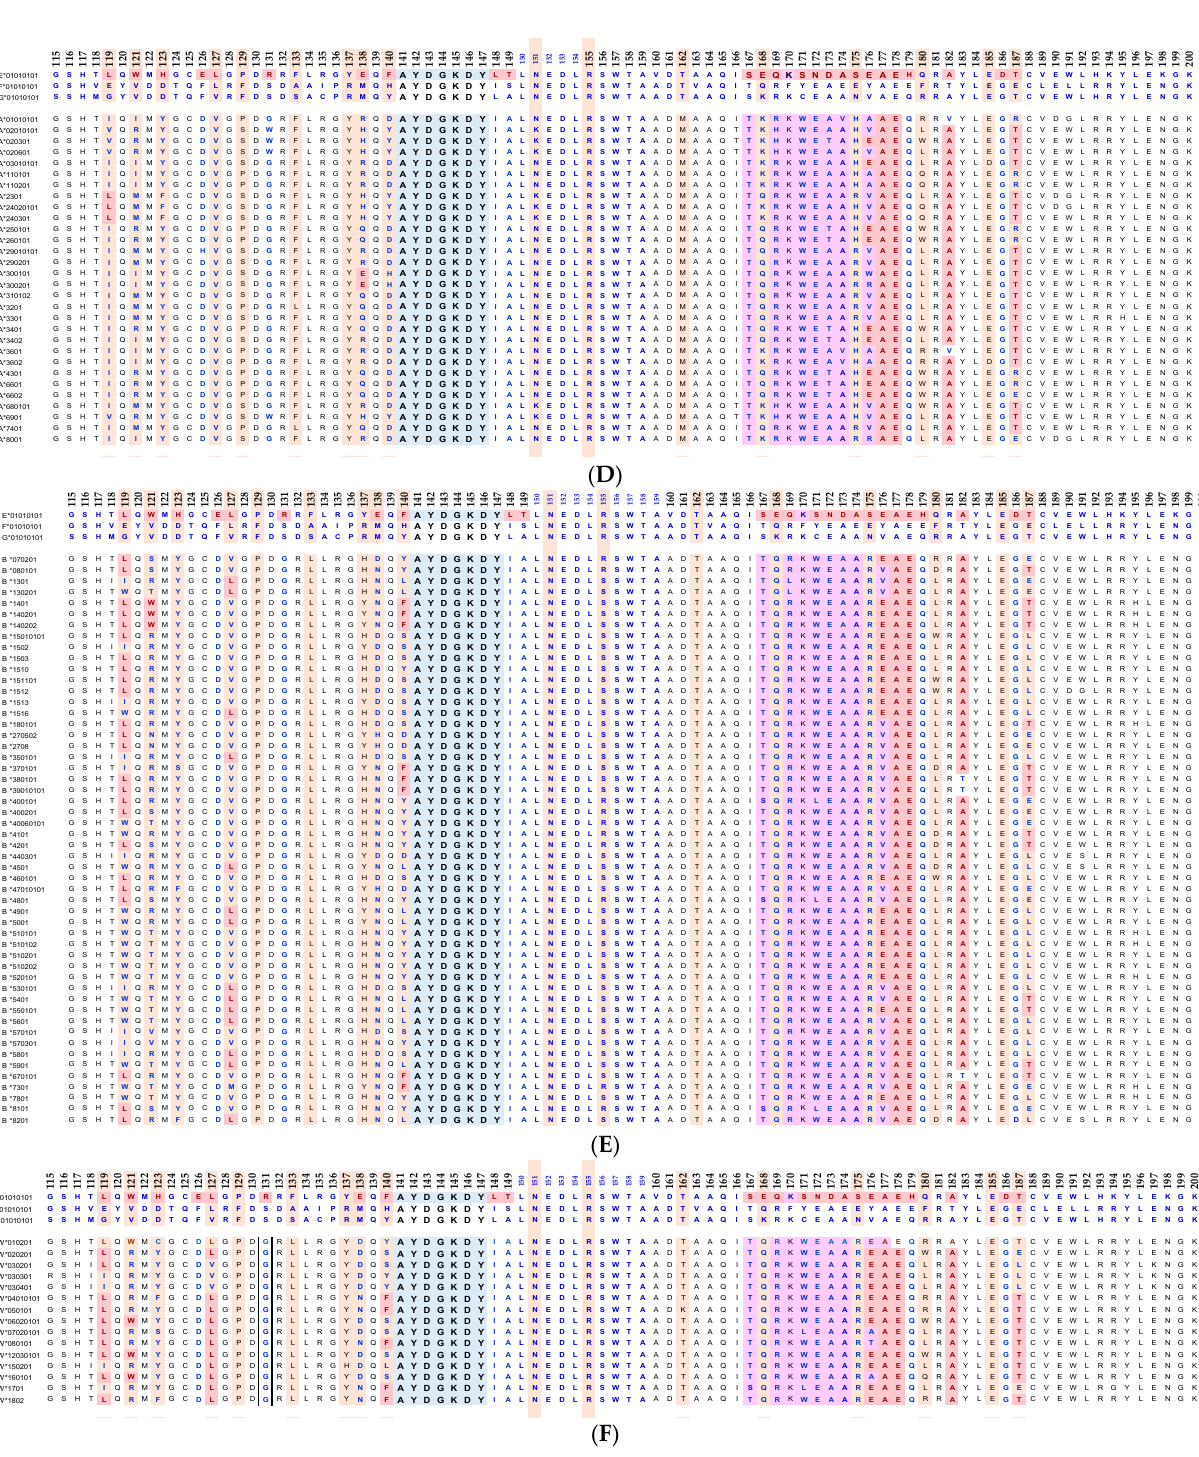
Figure 4. An overview of the polymorphic amino acid sequences of α 1 and α 2 domains in the classical (HLA ‐ Ia: HLA ‐ A/ ‐ B/ ‐ C) and non ‐ classical (HLA ‐ Ib: HLA ‐ E/ ‐ F/ ‐ G). Essentially, α 1 domain of HLA isomers carry monospecific sequences characteristic of each allele. This figure illustrates a specific sequence of HLA ‐ E, namely 90 SARDTA 95 in the α 1 ‐ domain, which is restricted exclusively to HLA ‐ E. This sequence is recognized by the mAb TFL ‐ 033 and the isolated sequence inhibited the mAb binding to HLA ‐ E. Similarly, a most commonly shared amino acid sequence ( 141 AYDGKDY 147 ) located in α 2 ‐ domain of all alleles of HLA ‐ Ia and HLA ‐ Ib is illustrated. Although the number of lleles of